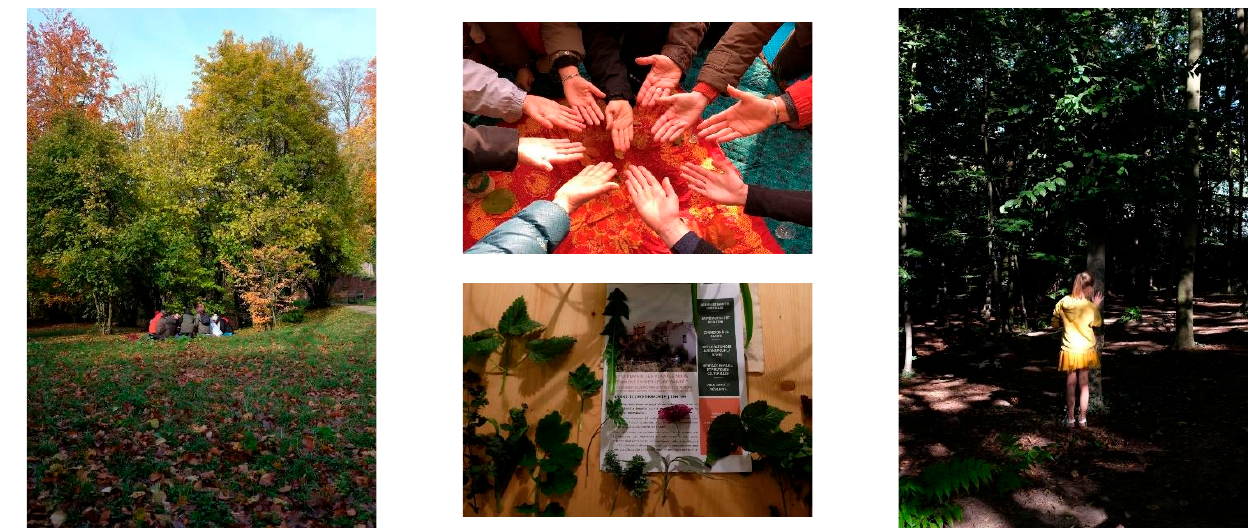
Figure 3. Moments from the BHG co-creation sessions that involved different co-researchers and places in